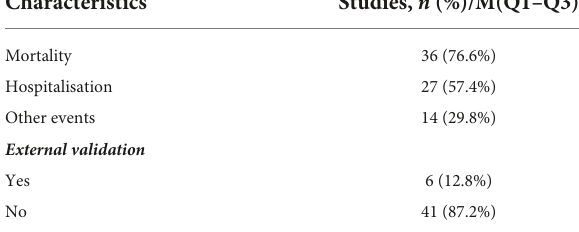
TABLE 1 Descriptive statistics of study